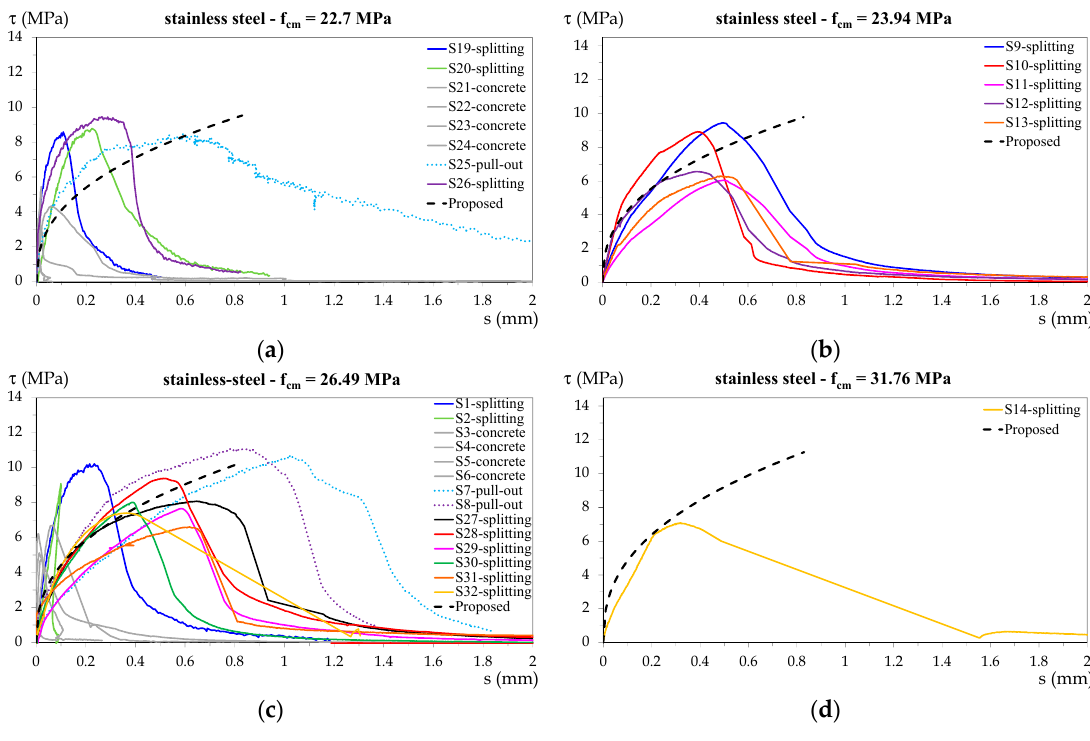
Figure 11. Bond stress–slip diagrams for specimens with stainless steel bars and ( a ) f cm = 22.70 MPa,